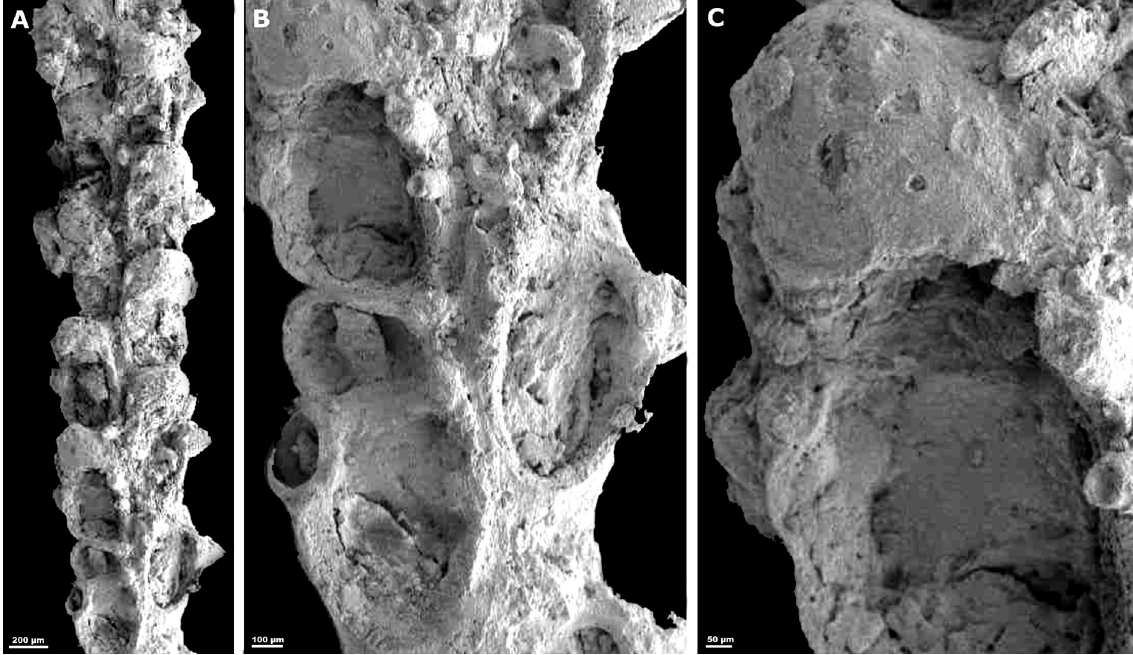
Fig. 3. ? Licornia sp. 1 (GIS/B 0539). A . Frontal view of the colony autozooids, ooecium and